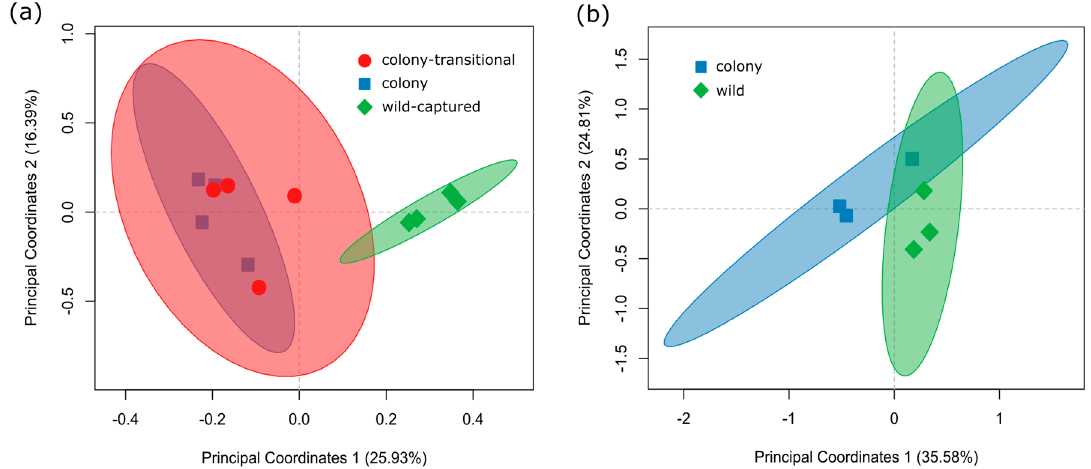
Figure 4. PCoA based on Bray-Curtis distances was used to assess microbial beta diversity of ( a ) colony, colony-transitional, and wild-captured fecal samples and ( b ) colony and wild foregut samples. Each symbol represents an individual vole. The distances between sample points represent the similarity of microbiota in the samples. Closer distances represent higher similarity of the samples. The shaded ellipse depicts the 95% confidence interval.